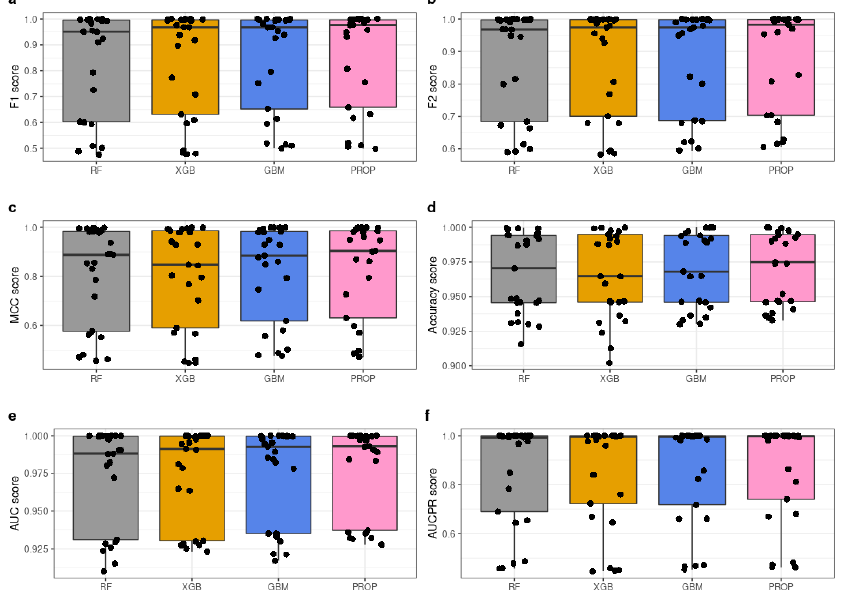
Figure 2. ( a – f ) Boxplots (center, median; box, interquartile range (IQR); whiskers, 1.5 × IQR) illustrat- ing the average performance distribution of classification